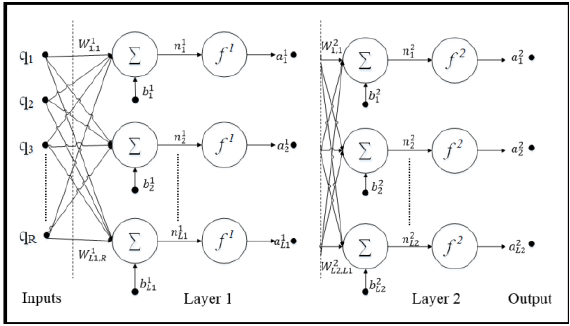
Figure 1.The schematic diagram of a two-layer neural network In this study the network is composed of inputs and two layers.